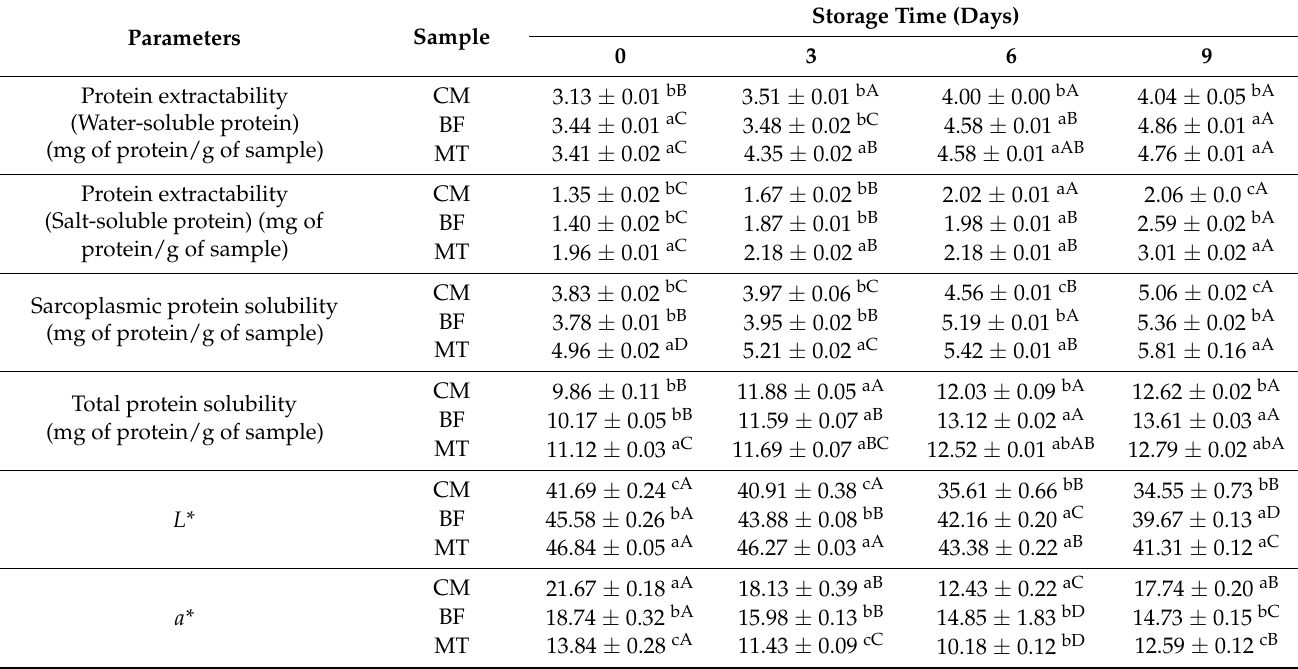
Table 1. Changes in protein extractability and solubility, and colour properties of camel meat (CM), beef (BF) and mutton (MT) over 9 days of refrigerated